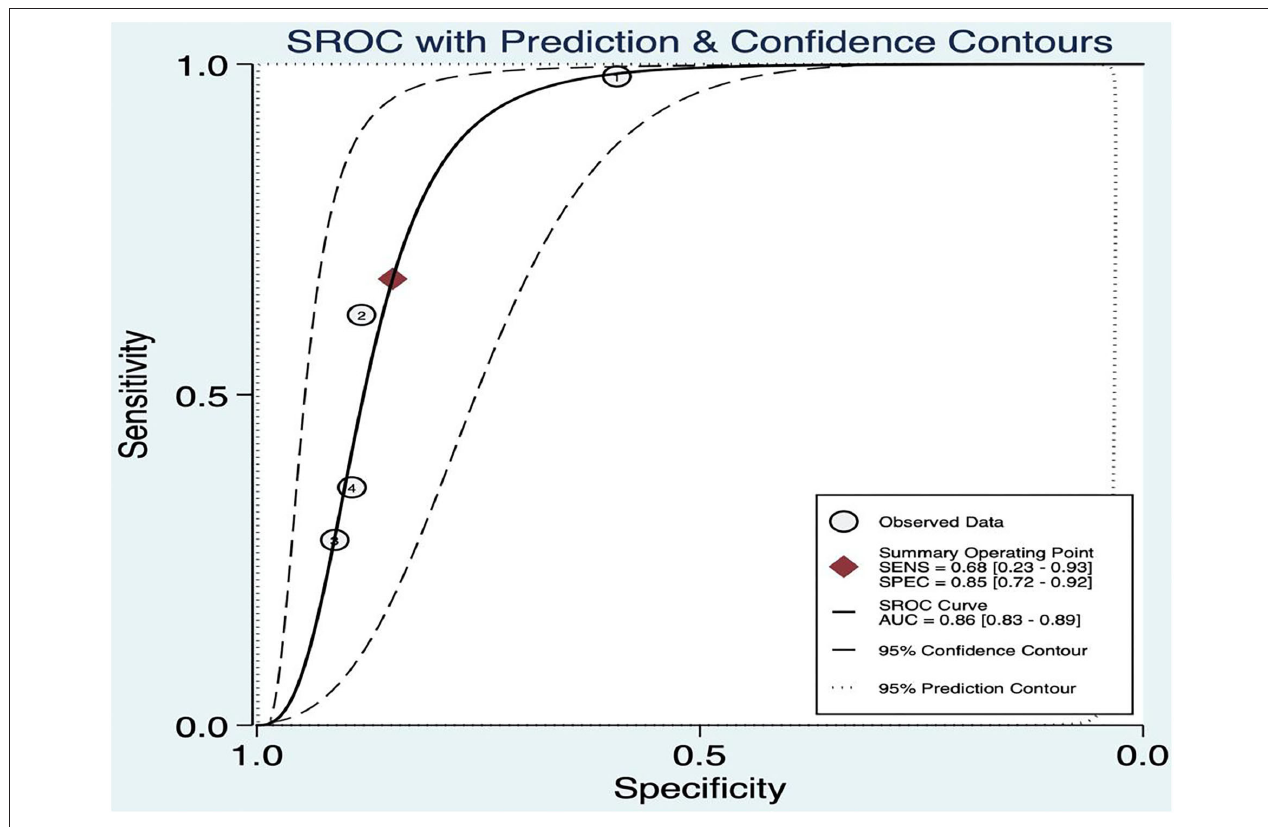
FIGURE 9 | Summary ROC of